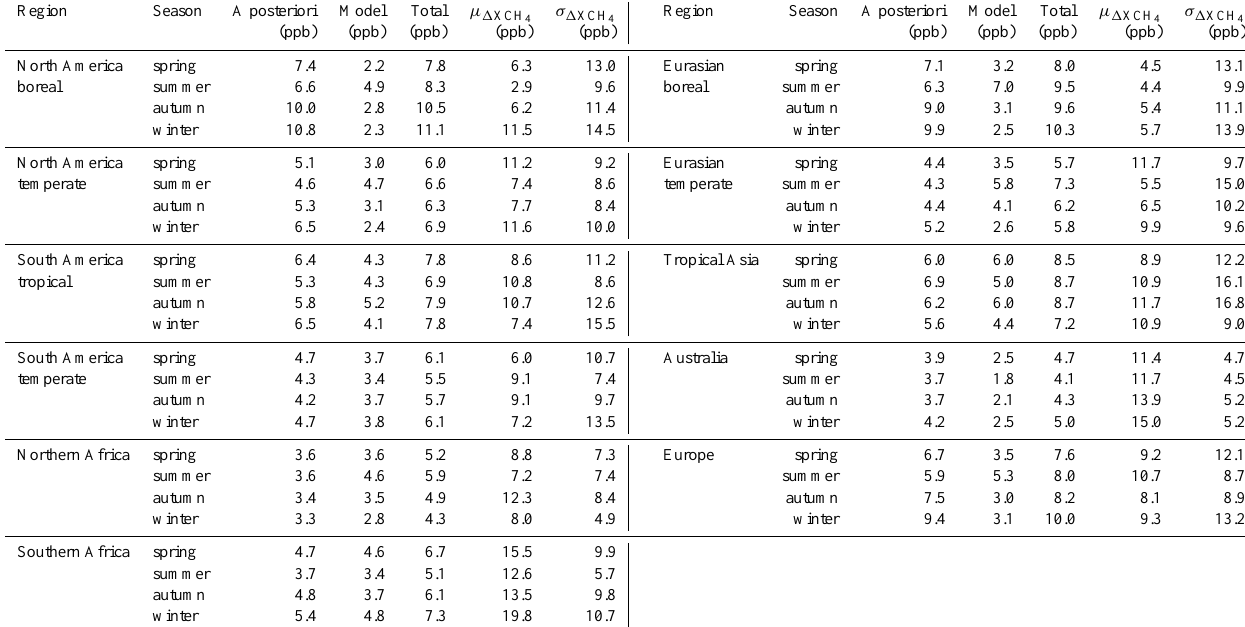
Table A2. Table showing the seasonal averages of the data plotted in Fig. 7 for each of the Transcom regions. The retrieved a posteriori error, the uncertainty related to the model XCO 2 , their combined total, and the mean and standard deviation of the GOSAT − MACC difference are all provided for each season and for each Transcom